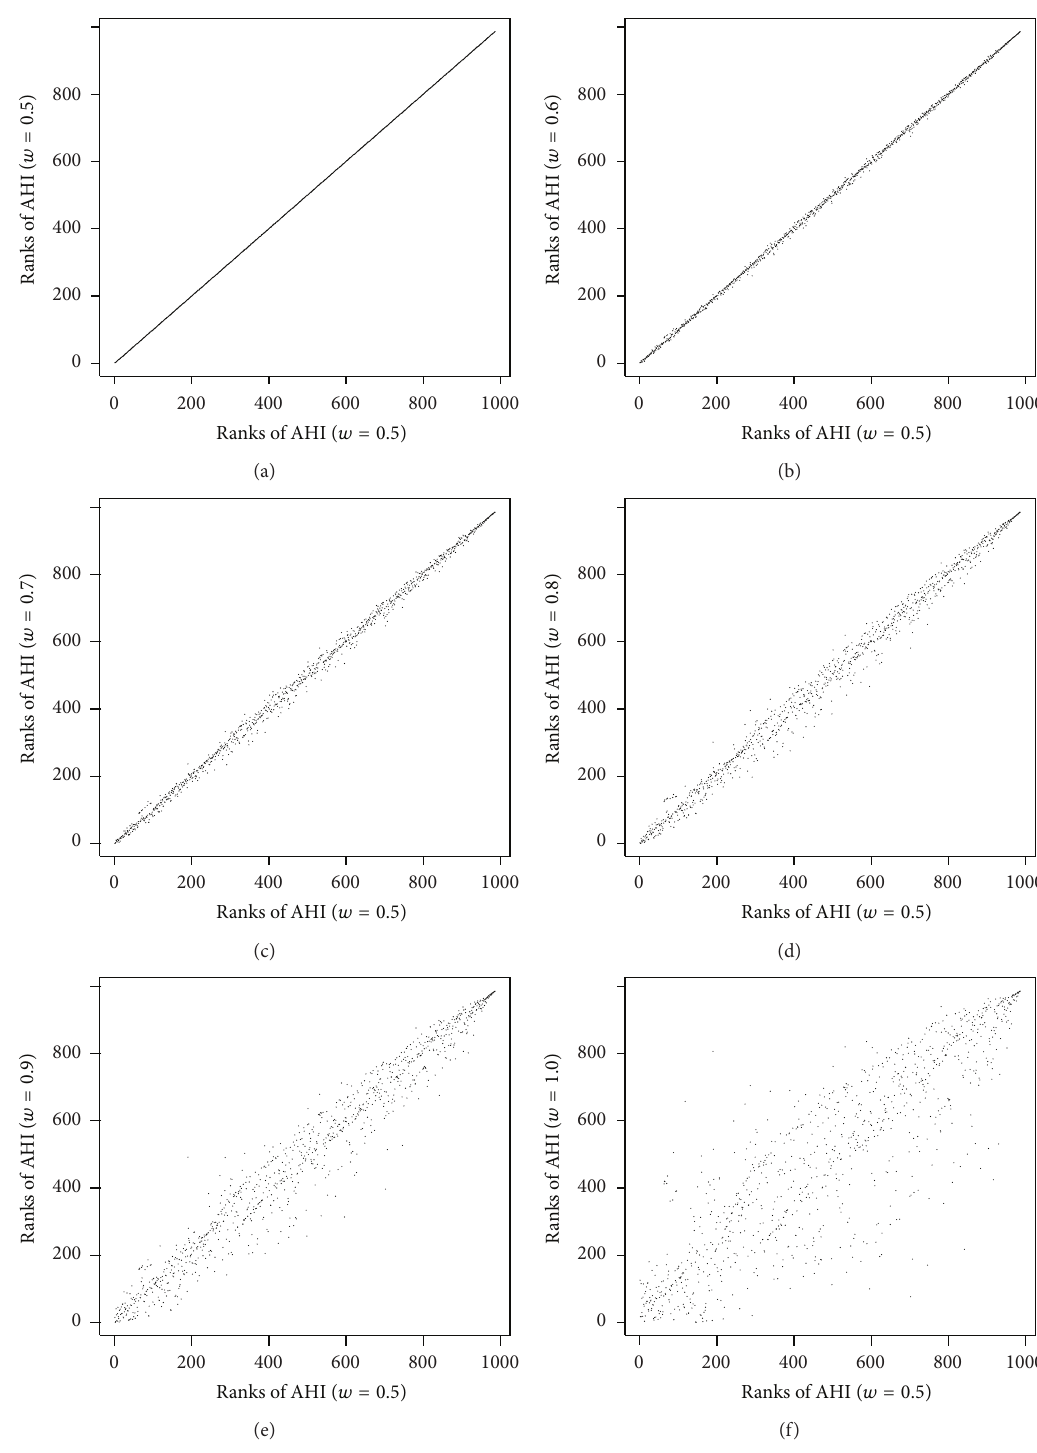
Figure 3: Scatter plots of AHI ranks between 𝑤 = 0.5 and other values of 𝑤